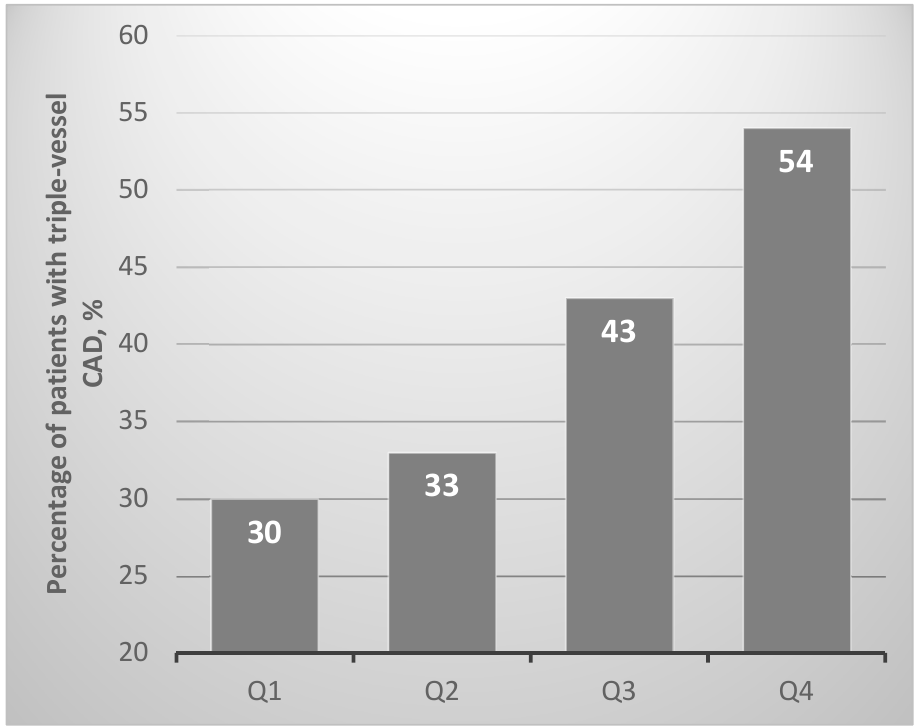
Figure 2. Percentage of patients with triple ‐ vessel coronary disease (CAD) in accordance with Lp(a) quartiles, mg/dL: Q1 < 7.2, Q from 7.2 to 24.3; Q3 from 24.4 to 67.8; Q4 ≥ 67.8. According to the median distribution of the monocyte subsets, triple ‐ vessel CAD was more common in patients with a lower percentage of classical CD14++CD16 − monocytes (values below the median, Figure 3A) and with a higher percentage of non ‐ classical CD14+CD16++ and intermediate CD14++CD16+ monocytes (Figure 3B,C). No significant differences in the absolute values were found.